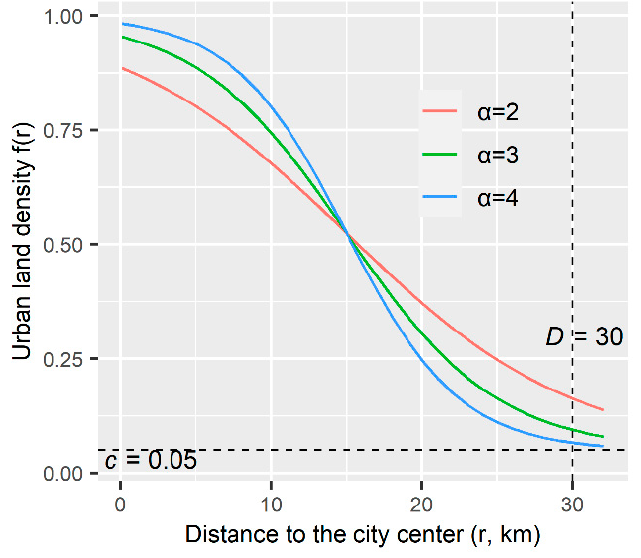
Figure 3. Curves of the urban land density function with different α parameters.